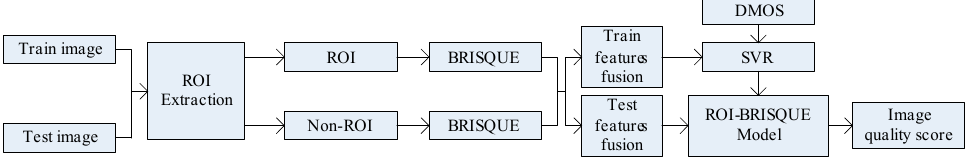
Figure 7. Model of Region of Interest—Blind/Reference Image Spatial Quality Evaluator.